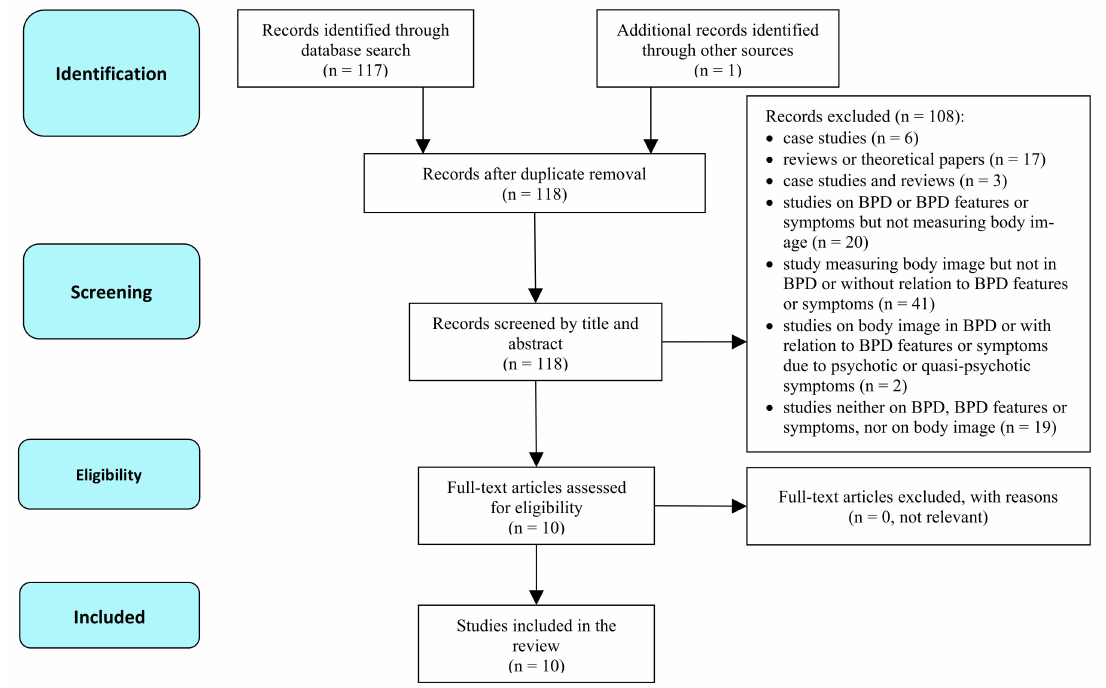
Figure 1. PRISMA flow diagram of the search